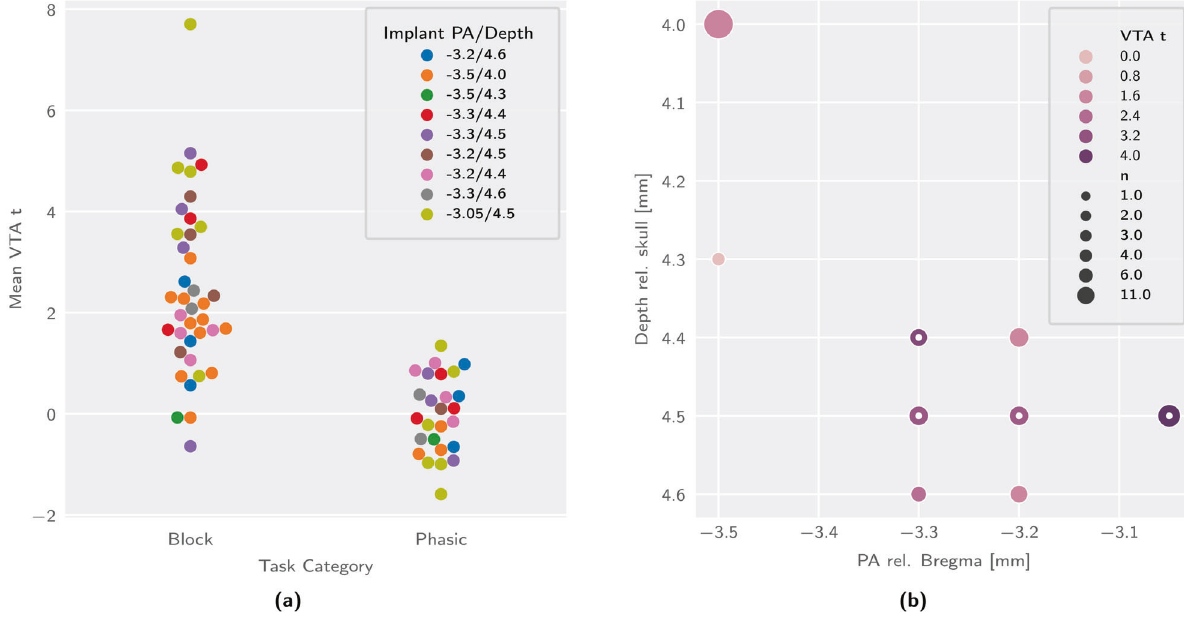
Fig. 2 VTA activation is sensitive to the stimulation protocol category and the implant coordinates, with different trends in block and phasic stimulation trials. Depicted are multifactorial (protocol and implant coordinates) comparisons of signal intensity in the VTA region of interest. a Task group comparison for animals targeted at all explored combinations of implant coordinates. b Implant coordinate comparison for block stimulation trials (inner dots indicate best category group). n sample size, PA posteroanterior, rel. relative